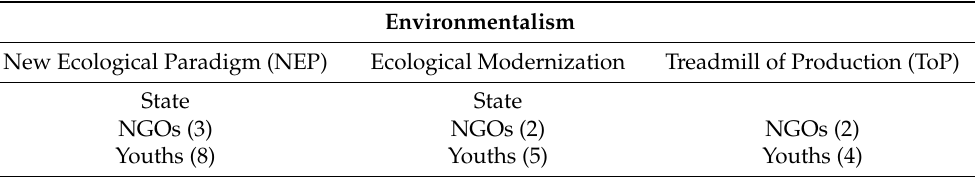
Table 1. The various perspectives on